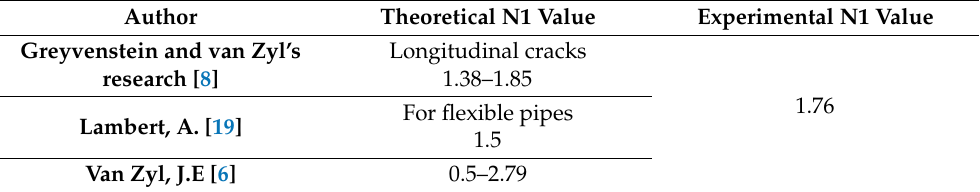
Table 6. Comparison of obtained N1 exponent by shown experiment to different theoretical